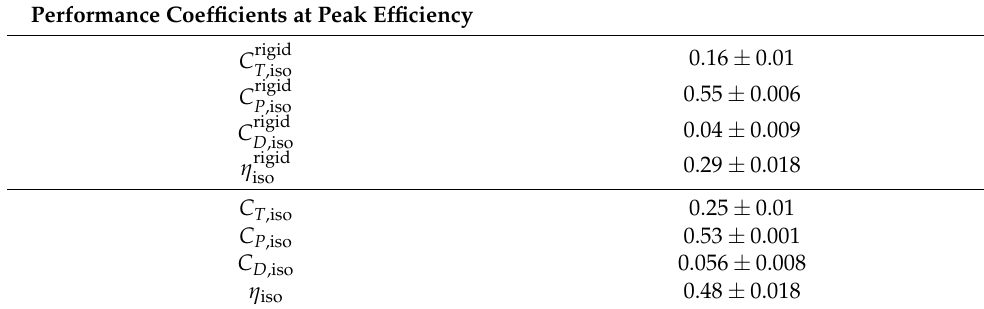
Table 2. Time-averaged net thrust, power and drag coefficients, as well as propulsive efficiency of = 0.25 and f = 1.5 Hz and an isolated flexible foil at A ∗ an isolated rigid foil at A ∗ 0 f = 1.3 Hz. The reported values for the rigid and flexible foils are taken at their peak efficiency. ± ( · ) represents the standard deviation calculated from 5 experimental